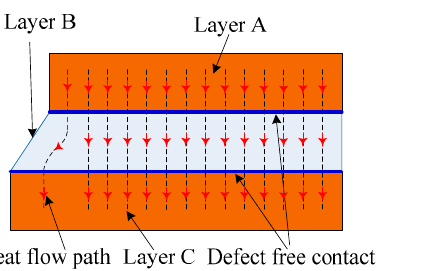
Figure 2. Joint characteristic degradation in multi-layer structure: ( a ) defect free connection; ( b ) rough surfaces with gradation defect.